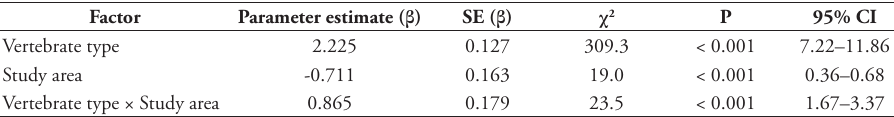
Table 1. Results from Cox’s proportional hazards analysis for measured factors and interactions poten- tially influencing the removal of wild cucumber seeds (n =